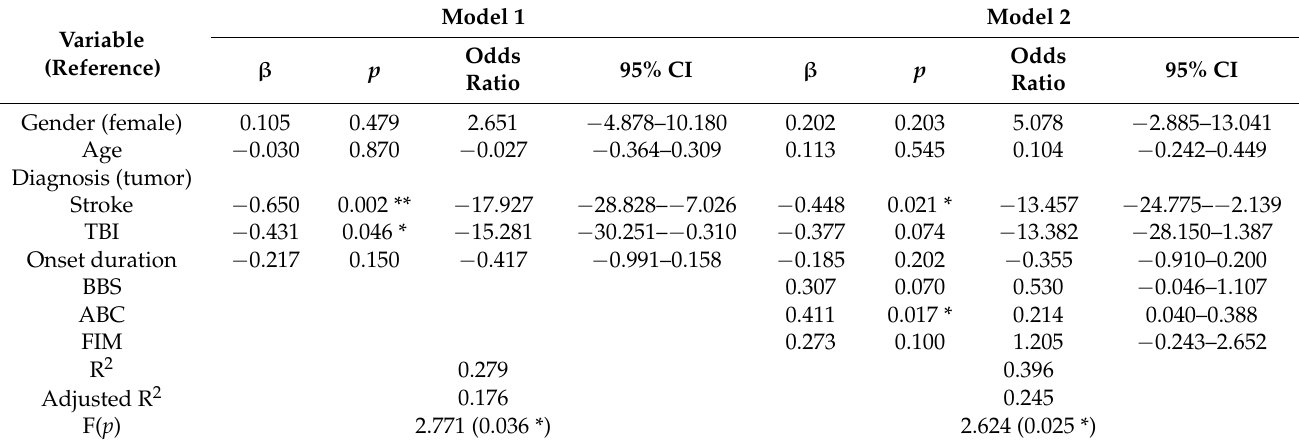
Table 6. Factors affecting health-related quality of